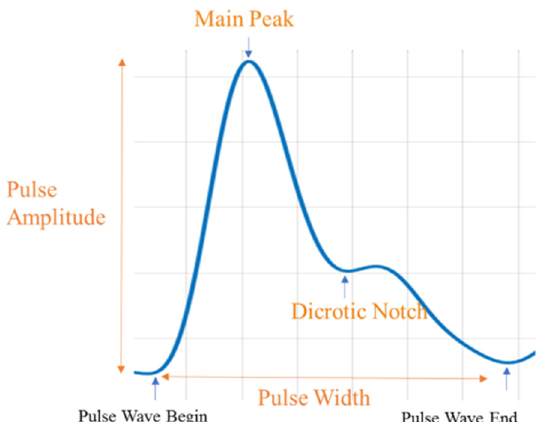
Figure 2. The characteristics of a PPG pulse chiefly include the main peak, dicrotic notch, pulse width, and pulse amplitude.